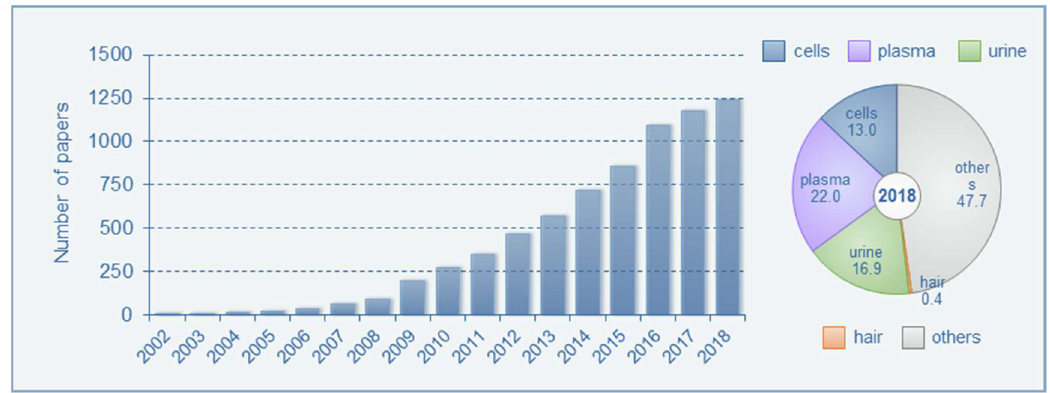
Figure 1. Number of Pubmed searches with the keywords, metabolomics, and biomarker, from 2002 to 2018 and the proportional contribution of biological samples in metabolomics research in 2018.